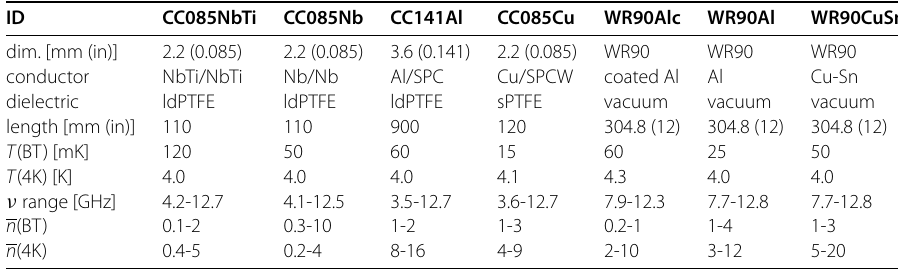
Table 1 Summary of waveguide and measurement parameters ID CC085NbTi CC085Nb CC141Al CC085Cu WR90Alc WR90Al WR90CuSn dim. [mm